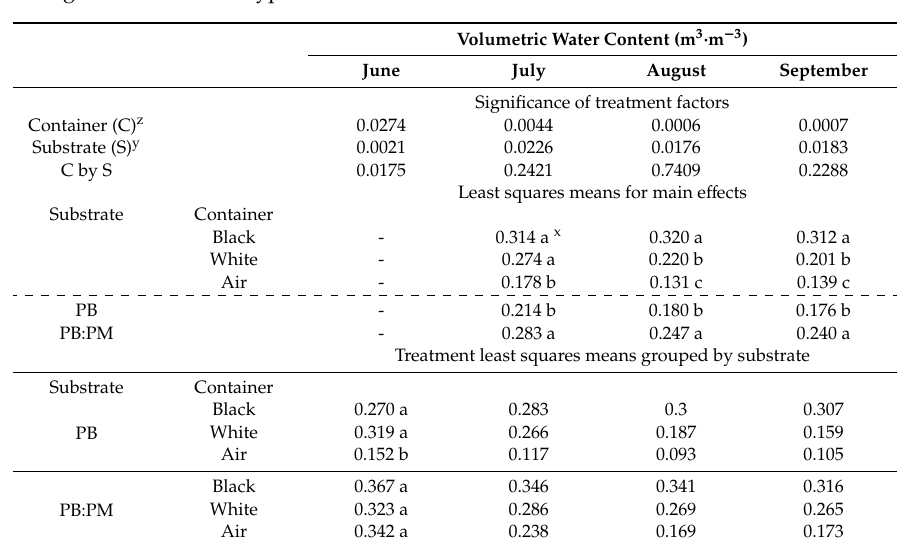
Table 5. Average daytime volumetric water content (n = 3) over a four-month period for ‘Green Giant’ arborvitae grown in di ff erent types of containers and substrates in